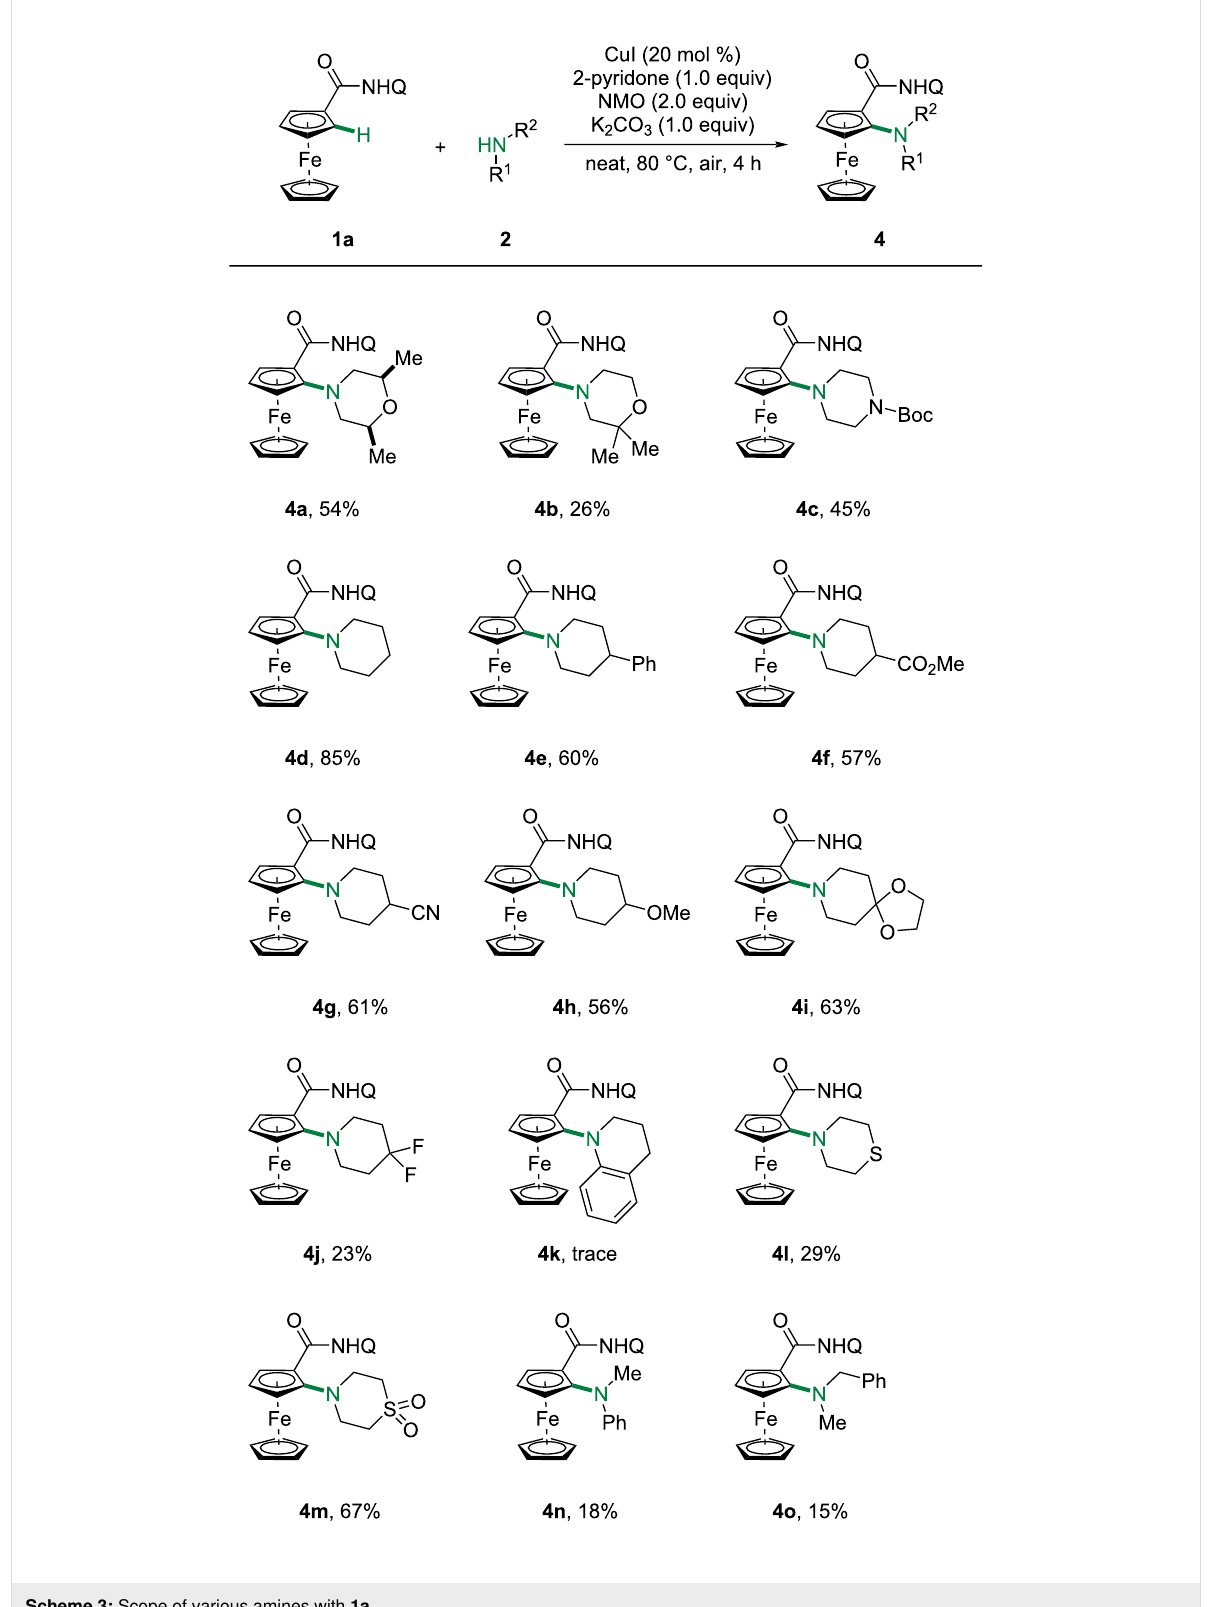
Scheme 3: Scope of various amines with 1a